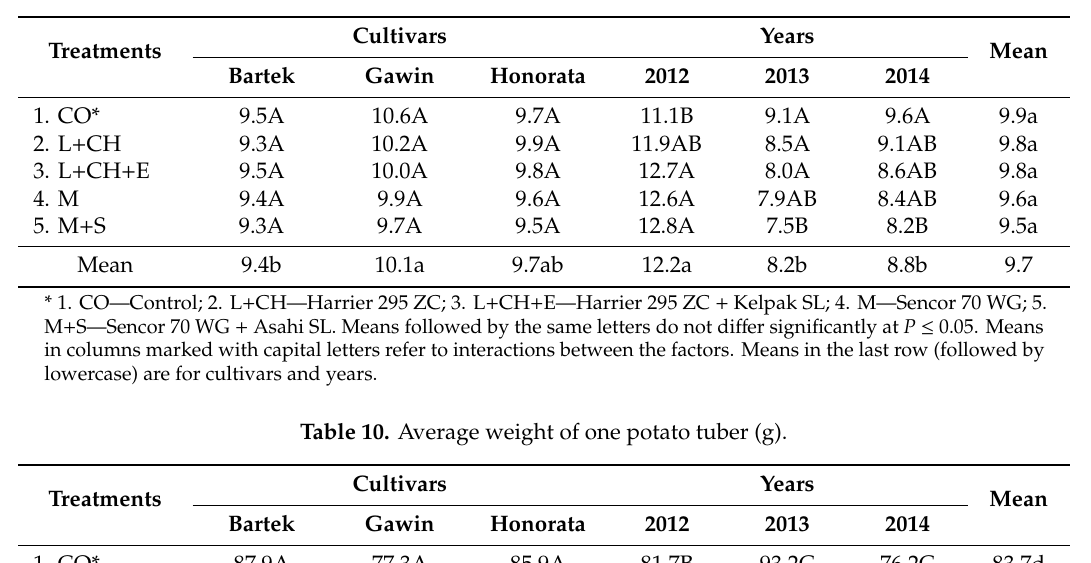
Table 9. Tuber number per one potato plant.